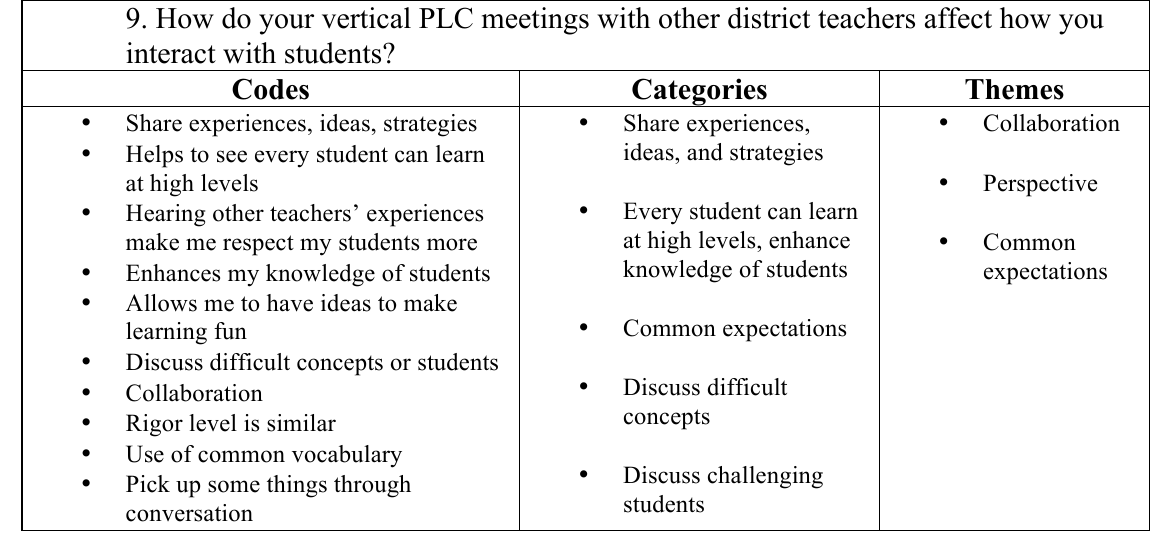
Teacher Question Nine and